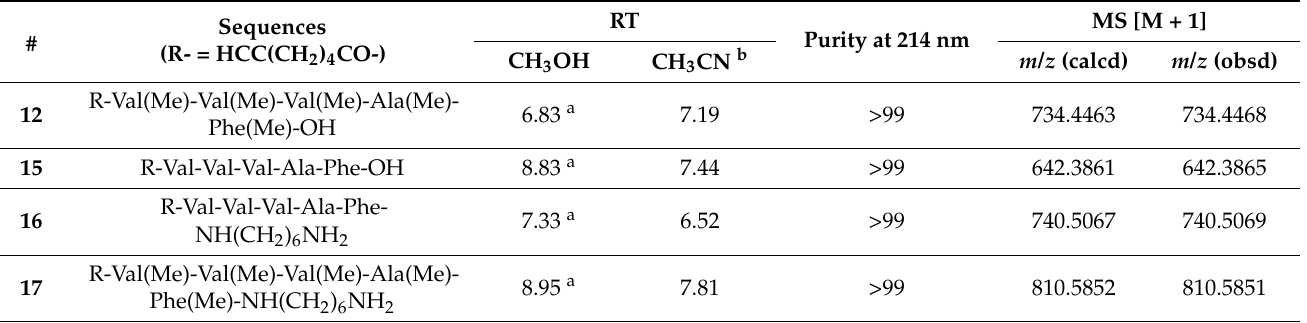
Table 1. Purity, retention times, and mass of almiramide